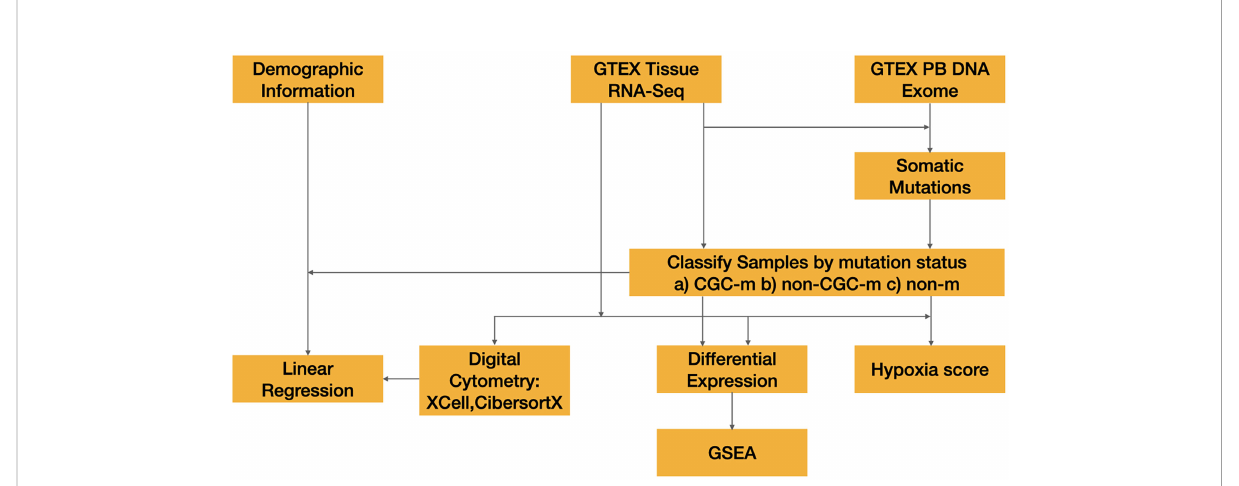
FIGURE 1 Overview of methods work fl ow used to detect microenvironment changes in normal